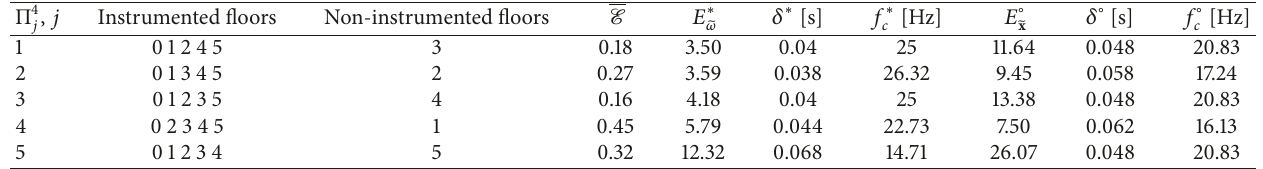
Table 3: Results with four instrumented floors.